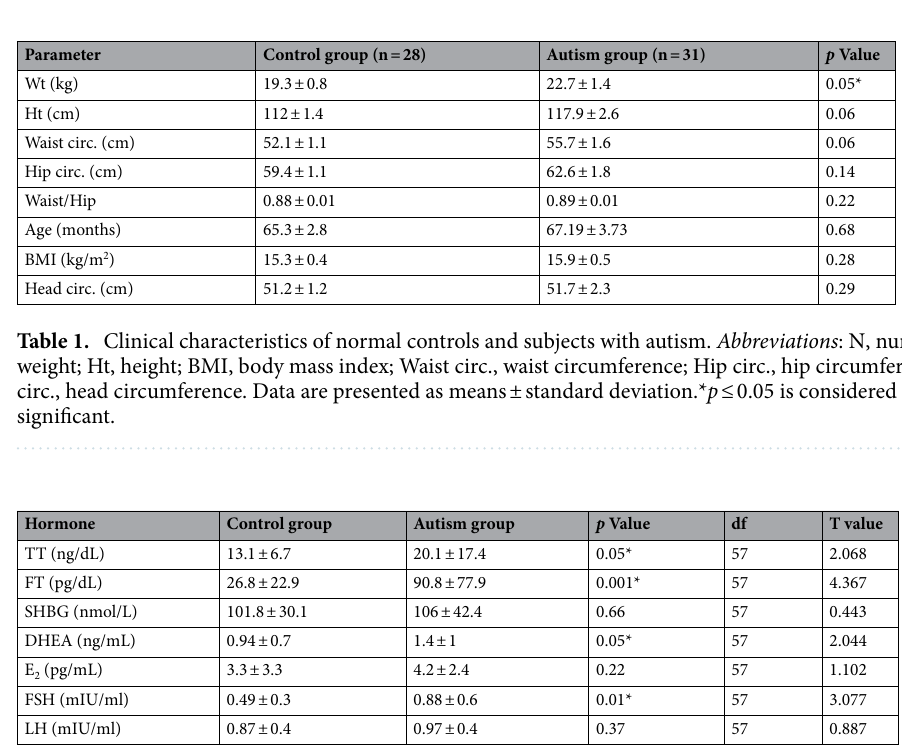
Table 2. Sex hormones and SHBG levels in the control and autism groups. TT, FT and SHBG were reported in our previously published study 11 . Data are presented as the mean ± standard deviation. * p ≤ 0.05 is considered statistically significant.